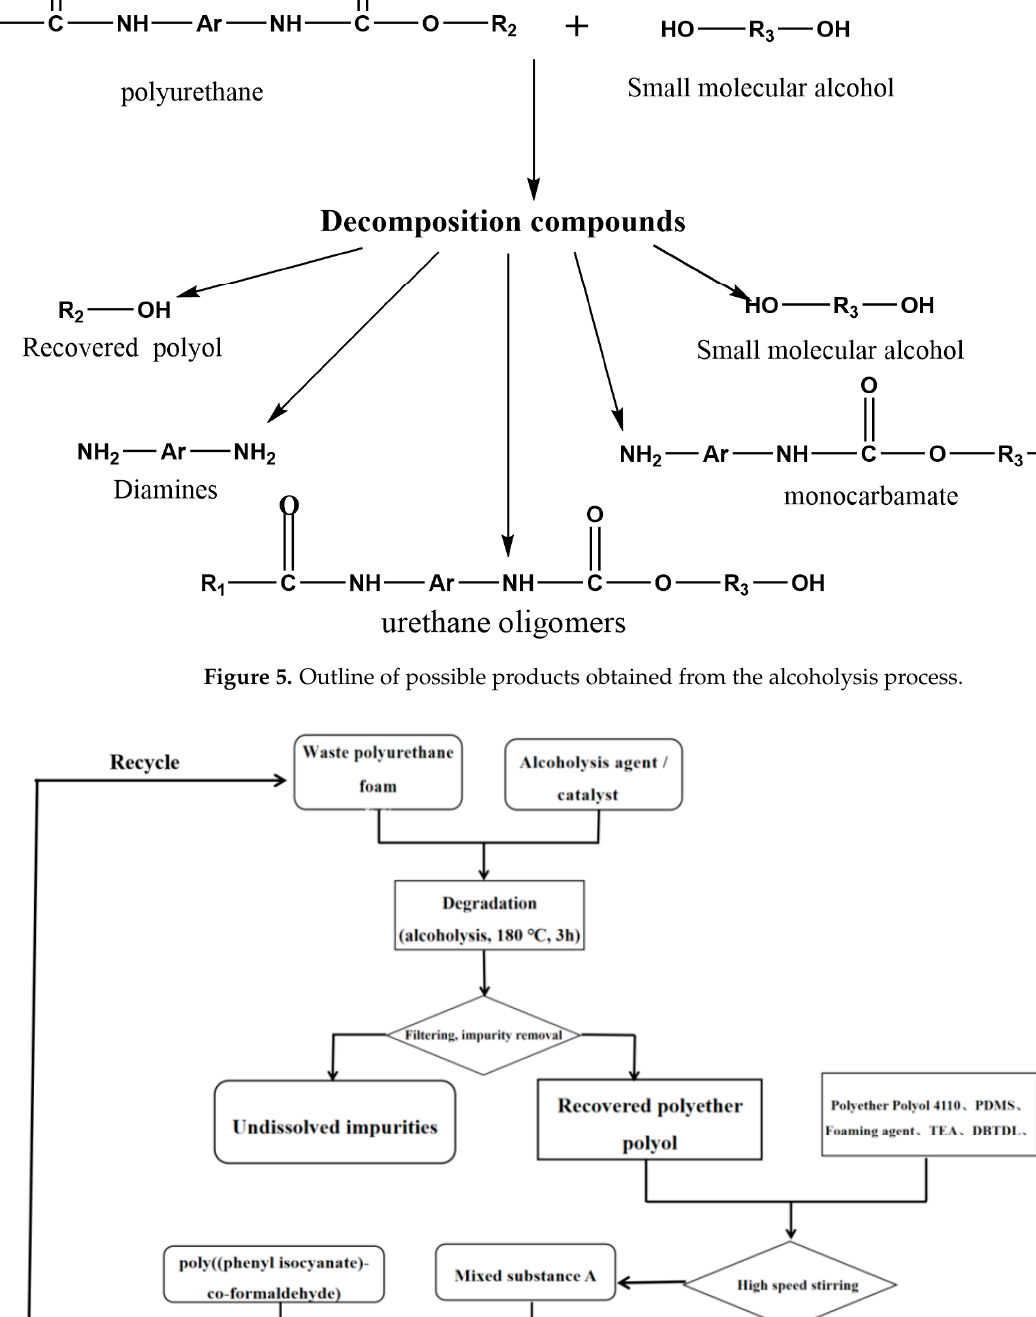
Figure 6. Flow chart of degradation and foaming of waste polyurethane in the production of recycled polyurethane foam.